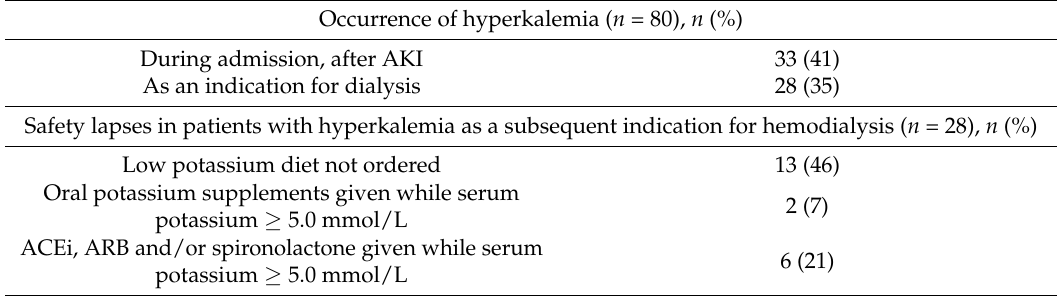
Table 4. Iatrogenic contributors to hyperkalemia after Acute Kidney Injury.